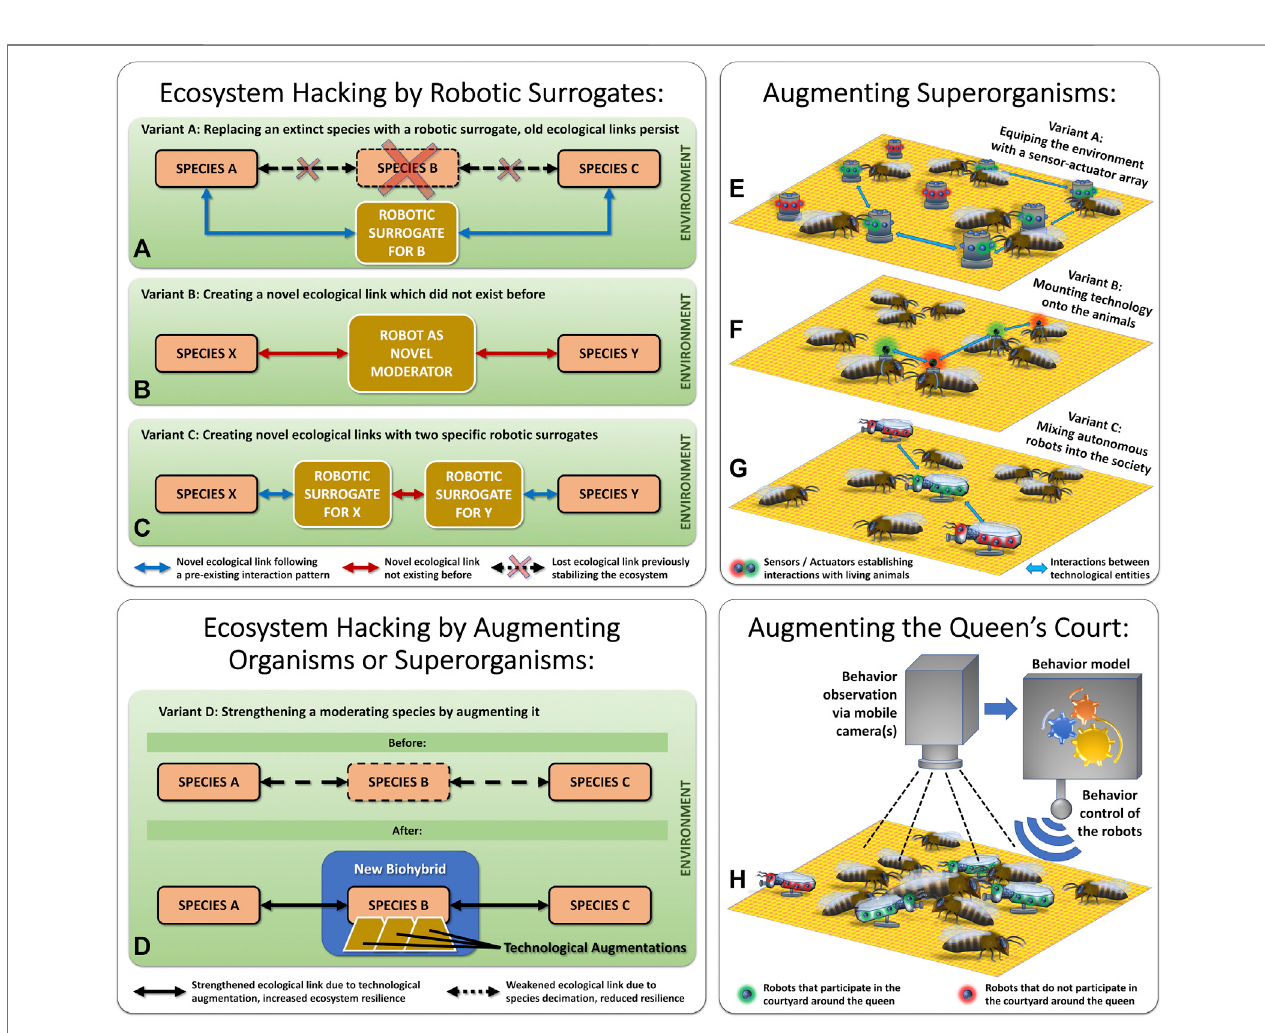
FIGURE 10 | Variants of “ Ecosystem Hacking ” and “ Organismic Augmentation ” . Left top sub fi gures (A – C) show variants of ecosystem hacking approaches that rewireecosystems.Righttopsub fi gures (E – G) showvariantsoforganismicaugmentationforsuperorganismsorothersocialanimals.Theleftlowersub fi gure (D) depicts howexistingecologicalconditionscanbestrengthenedbyaugmentingacentralkeystonespecies.Therightsub fi gure (H) depictsaugmentingonlyacentralsubelement of a superorganism, the queen ’ s court.